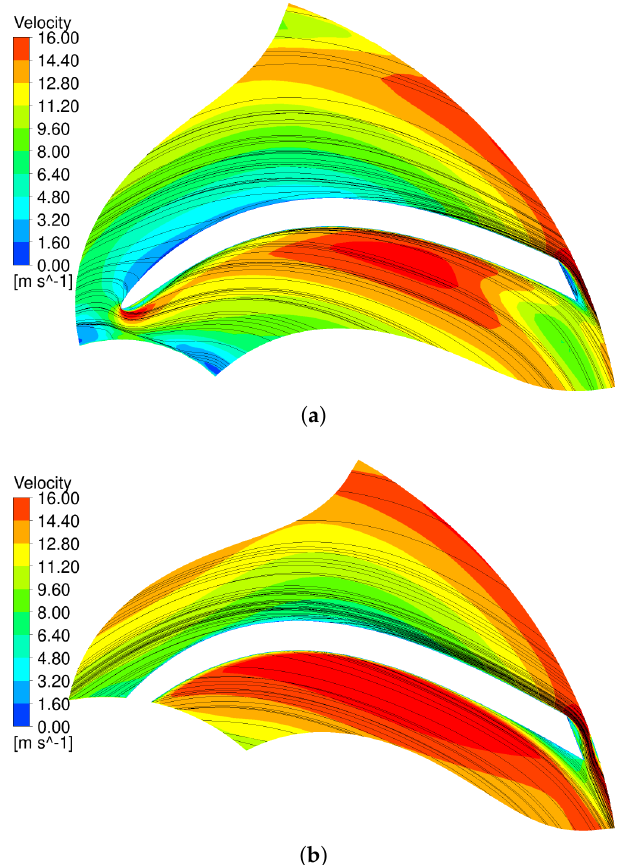
Figure 18. Velocity contours and streamline in the plane z = 5 mm for the baseline ( a ) and the optimized ( b ) geometries.